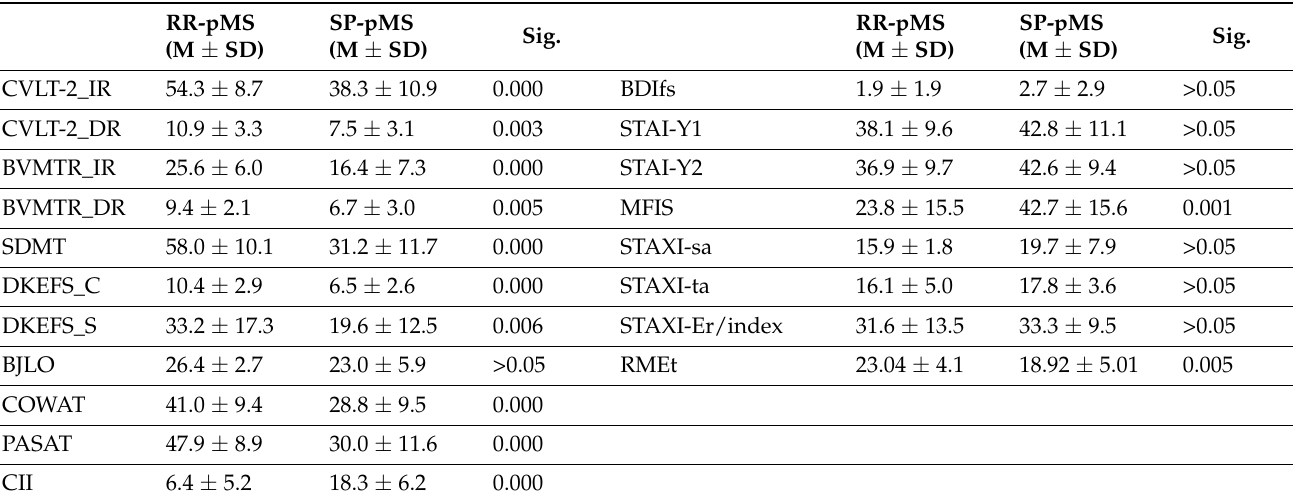
Table 2. Cognitive and mood assessment, and comparison between RR-pMS and SP-pMS based on t -test analysis.